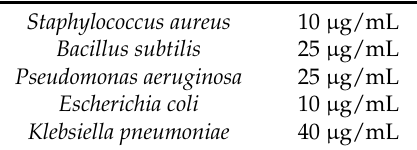
Table 3. MIC values of silver nanoparticles